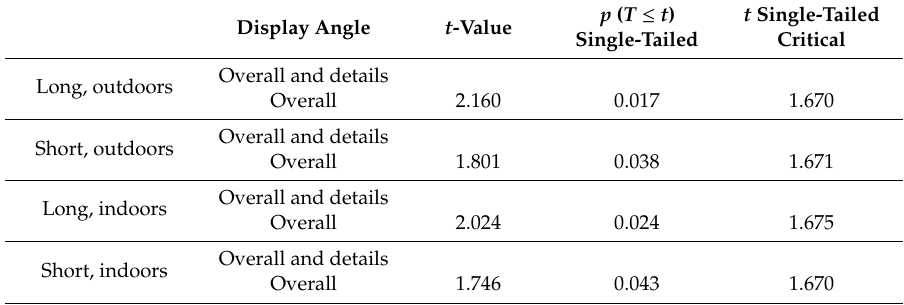
Table 9. The t -tests for the impact of di ff erent display angles on consumers’ perceptions of quality. Display Angle t